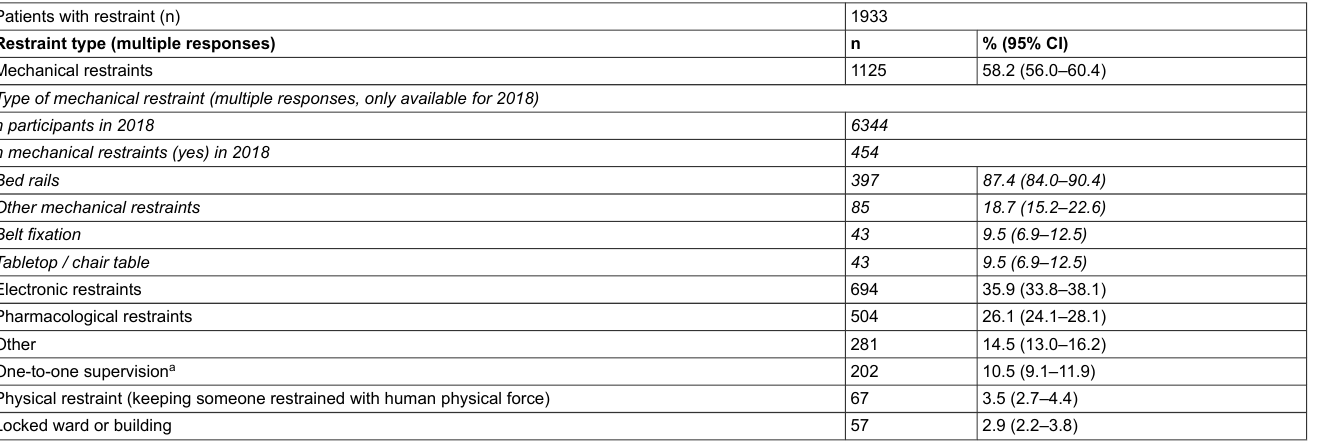
Table S3: Restraint type.